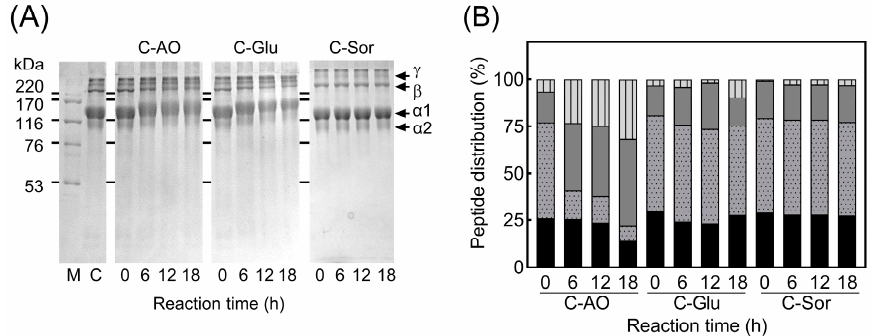
Figure 2. Molecular mass profiles of glycated collagens and their pepsin-trypsin digested peptides. ( A ): SDS-PAGE of glycated collagen. M: molecular mass markers; C : intact collagen. α1 and α2 in- dicate collagen subunits, β and are dimer and trimer chains of collagen subunits, respectively. ( B ): Gel permeation chromatography of digested glycosylated collagens. In the bar chart of molecular mass distribution, digested peptides were represented as follows: >10 kDa (